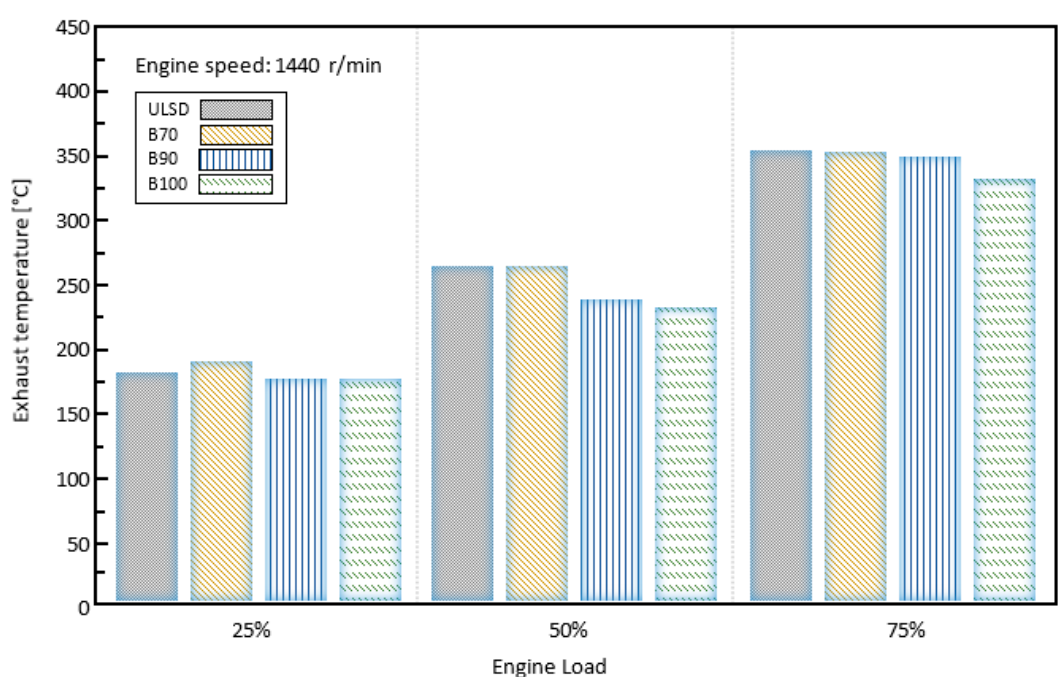
Figure 9. Tested fuels’ influence on the exhaust gas temperature at 1200 rpm .